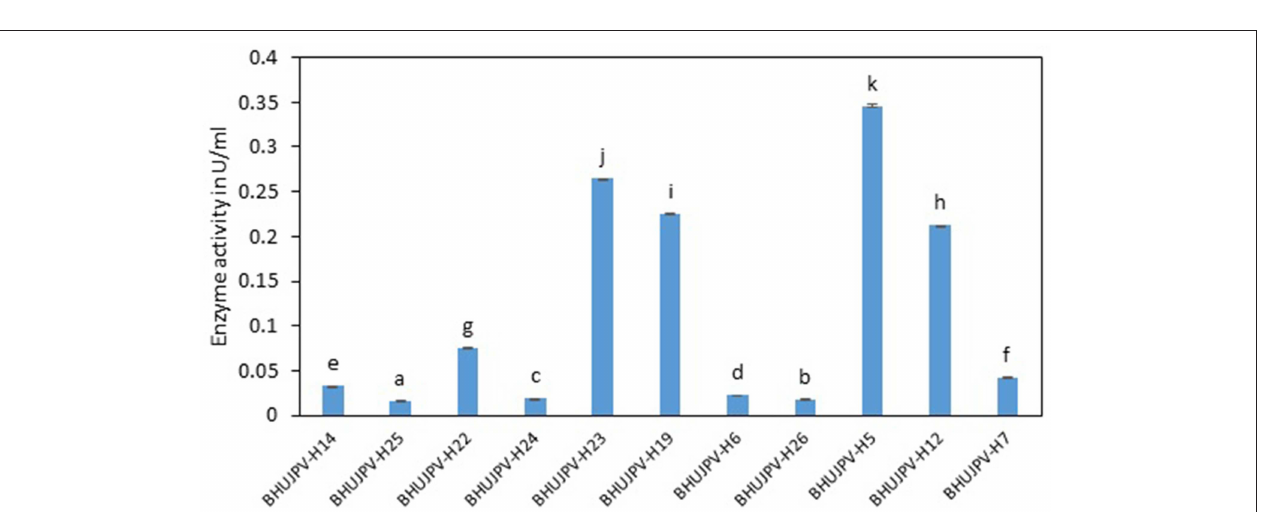
FIGURE 1 | Total cellulase activity of the isolated bacterial strains at 72h of enzyme harvest. Values are the mean ± SE (standard error). Mean values in each bar with the same alphabet superscript(s) do not differ significantly, but different alphabet superscript is showed significantly different between each treatment by Duncan post hoc test ( p ≤ 0.05).